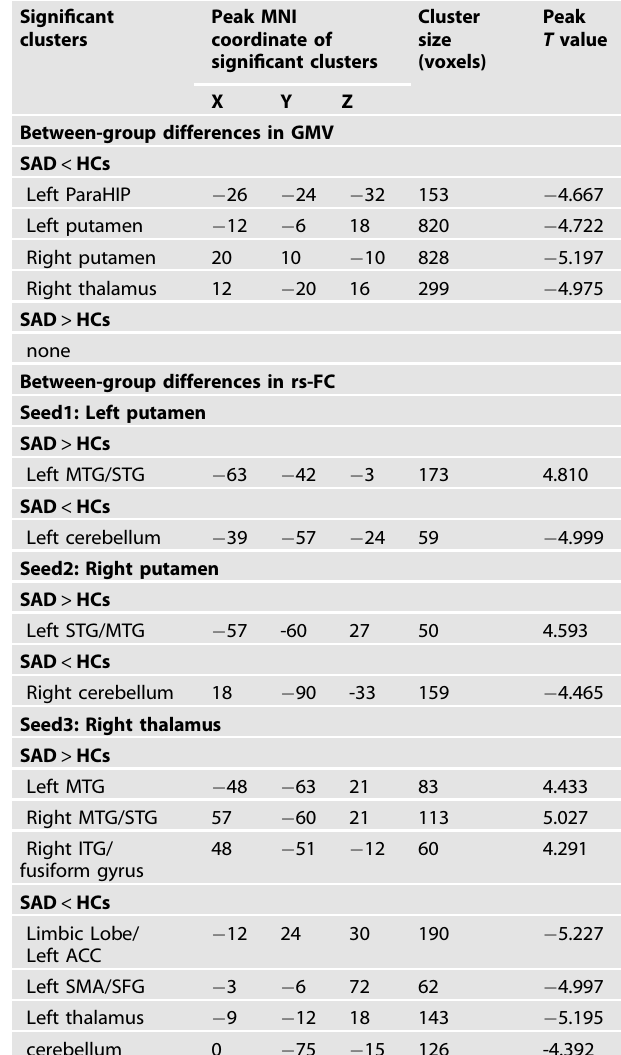
Table 2. Brain regions with signi fi cant differences in GMV and rs-FC between SAD patients and